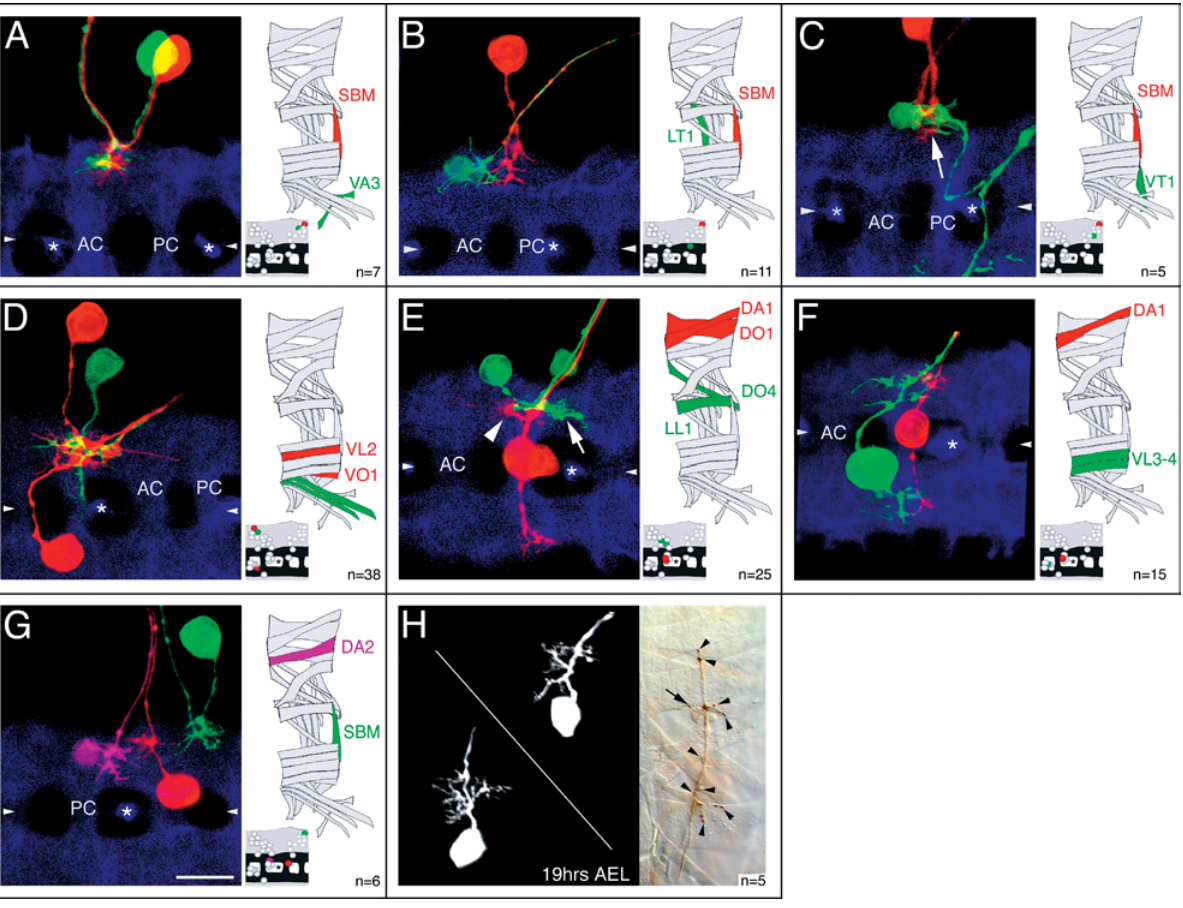
Figure 2. Central Myotopic Representation of the Muscle Field Motor neurons with external (A–C) and internal (D–G) muscle targets (indicated in muscle diagrams) were retrogradely labelled in 15-h-old wild- type embryos. The neuropile, visualised with anti-HRP, is shown in blue. (A) Motor neurons with ventral and lateral external muscle targets at a similar location in the anteroposterior axis elaborate their dendritic arbors in a common region of the neuropile, within the SN dendritic domain, which represents external muscles. (B) Differences in muscle positions in the anteroposterior axis are reflected centrally by corresponding distinctions in the anteroposterior locations of motor neuron dendritic fields. (C) Muscle VT1 is innervated by a TN motor neuron (and frequently also by its contralateral homologue, partly shown). Dendrites of the VT1 motor neuron (arrow) coincide with those of the SBM motor neuron of the next anterior segment. Note that in (A) the position of the SBM dendritic field is shifted somewhat anteriorly relative to the commissural landmarks as compared to (B) and (C). We observe such shifts relative to the commissural landmarks in 13% ( n ¼ 52) of SBM (and other) motor neurons at this developmental stage. Importantly, the relative positions of dendritic fields within the myotopic map remain constant. Such shifts relative to the commissures may be linked to the condensation of the nerve cord, which is underway at this stage. (D) Motor neurons with ventral internal muscle targets elaborate their dendrites in the ISN dendritic domain, which is located in the posterior part of the next anterior segment. (E) Motor neurons with dorsolateral internal targets put their dendrites (arrow) in the most-posterior part of the ISN dendritic domain, i.e., posterior to the dendritic domain, which represents dorsal internal muscles (arrowhead). (F) Motor neurons innervating ventral (ventral longitudinal 3–4 [VL3–VL4]; RP3) and dorsal (DA1; aCC) internal muscles elaborate their dendritic arbors in distinct regions of the ISN dendritic domain. Both motor neurons shown are bipolar and each has a second, smaller contralateral (with respect to the target muscle) dendritic arbor that mirrors the distribution of the ipsilateral dendrites. (G) Muscle DA2 is innervated by the RP2 (red) and a U/CQ neuron (magenta). The RP2 axonal trajectory through the posterior root of the ISN demarcates the boundary between ISN (magenta and red) and the SN (green) dendritic fields. (H) On the left are two examples of RP2 neurons filled in different 19-h-old embryos with Lucifer Yellow. As at the earlier stages shown in (G), most of the RP2 dendrites project anterior of the axon into the ISN dendritic domains representing dorsolateral and dorsal internal muscles. On the right is a Nomarski micrograph of a Lucifer Yellow-filled RP2 axon in the periphery at 19 h AEL. Swellings (arrowheads), likely neuromuscular junctions, are not specific to muscle DA2 (arrow), but are seen on all dorsolateral and dorsal muscles. Anterior is left and dorsal is up. Symbols and abbreviations: triangles, ventral midline; AC, anterior commissure; PC, posterior commissure; asterisks, dorsoventral channels (landmarks for the segment borders). Scale bar (not applicable to diagrams of CNS and muscle field and micrograph of muscle field in [H]): 10 l m. DOI: 10.1371/journal.pbio.0000041.g002